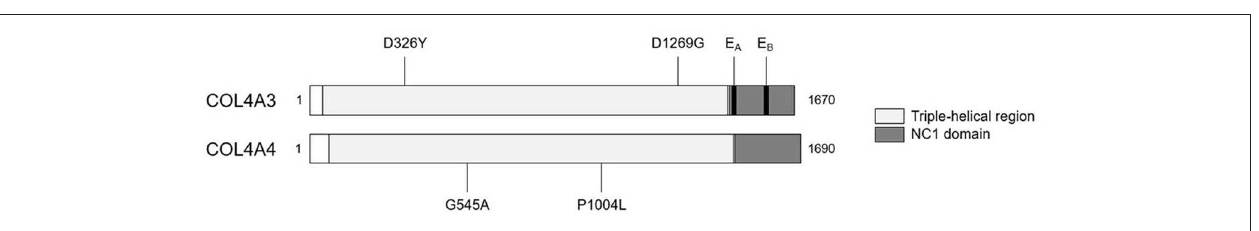
A 42-year-old female patient received a bone marrow